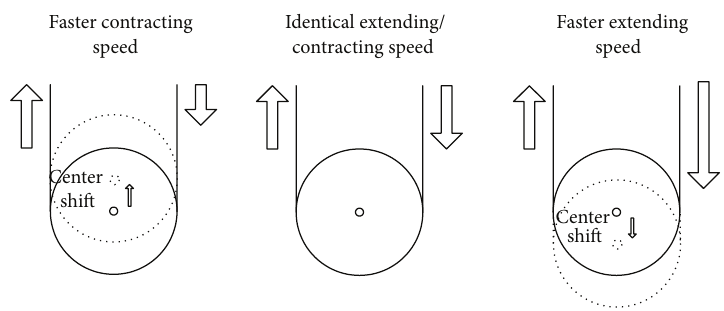
Figure 1: Three scenarios of synchronization between extending and contracting strings.